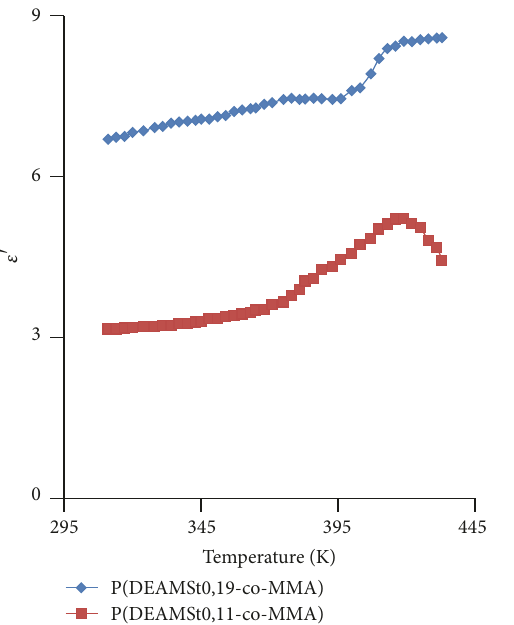
Figure 15: The change of the dielectric constants versus temperature for P(DEAMSt0.11-co-MMA) and P(DEAMSt0.19-co-MMA).